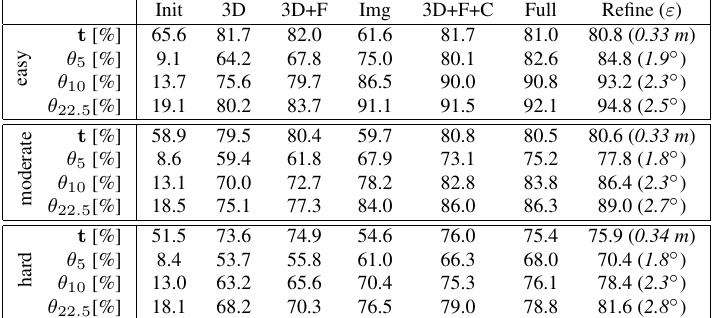
Table 2. Evaluation of the pose estimation results.